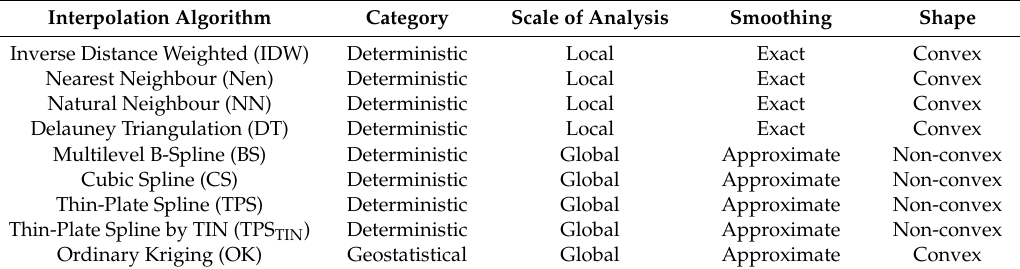
Table 2. General characteristics of tested interpolation algorithms. Detailed explanation of terms can be found in